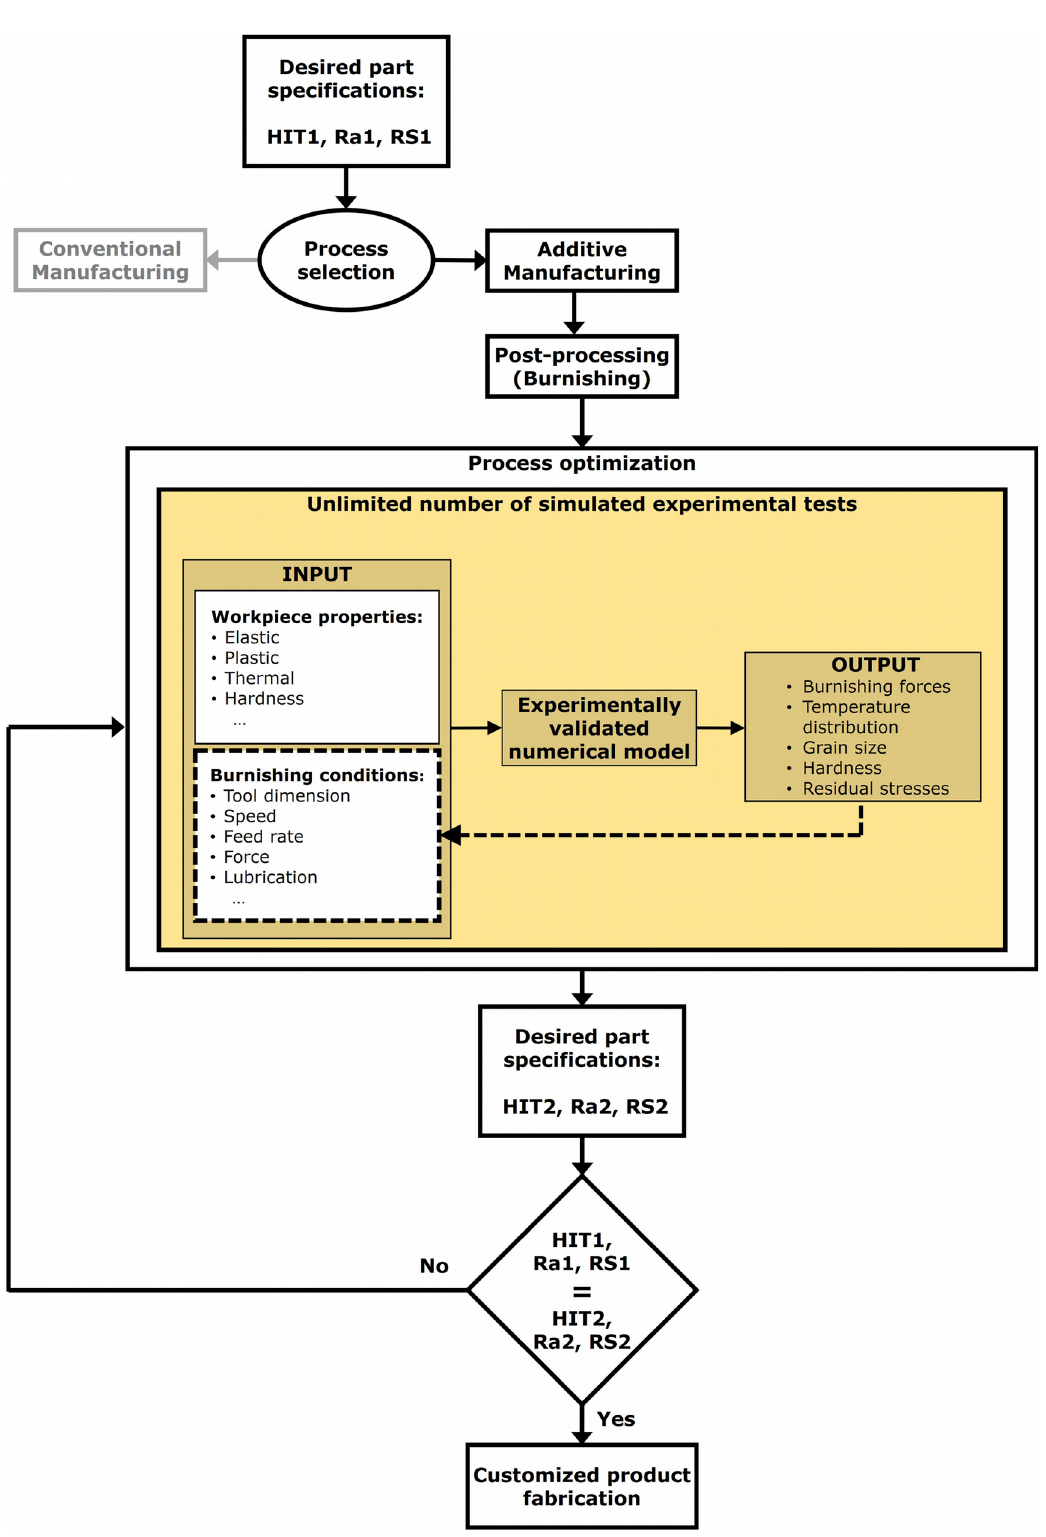
Figure 5. Process selection and optimization workflow (Sanguedolce et al,